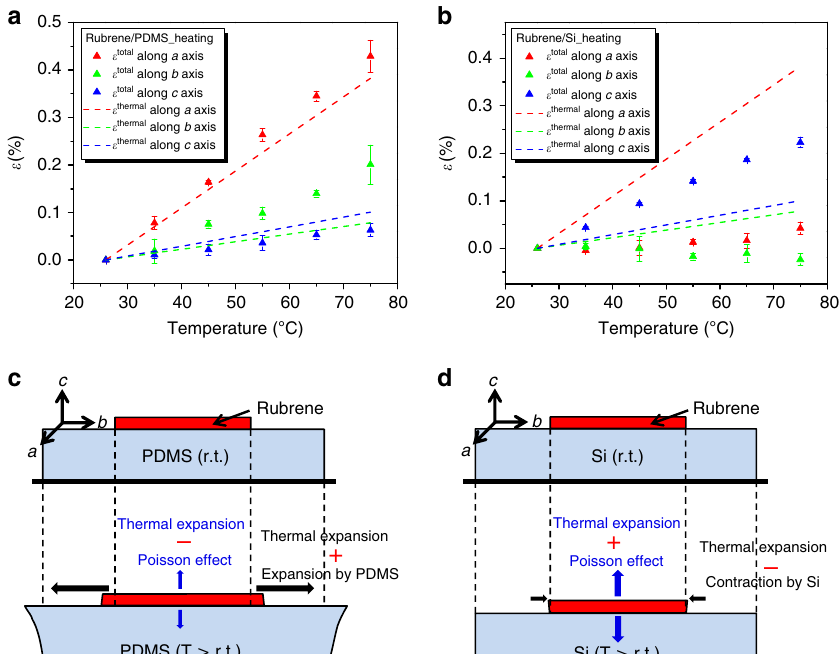
Figure 2 | Total elastic strain in rubrene single crystals. ( a ) Average total elastic strains e total of rubrene along a , b and c axes as a function of temperature for crystals laminated on PDMS, which are different from the corresponding thermal strains e thermal expected for free rubrene crystals (dashed lines). ( b ) Average e total of rubrene along a , b and c axes as a function of temperature for crystals laminated on Si, different from the corresponding e thermal predicted for free rubrene crystals (dashed lines). The error bars in e total were based on the s.d. calculated as demonstrated in Supplementary Table 2. ( c ) Illustration of strain components for rubrene on PDMS. ( d ) Illustration of strain components for rubrene on